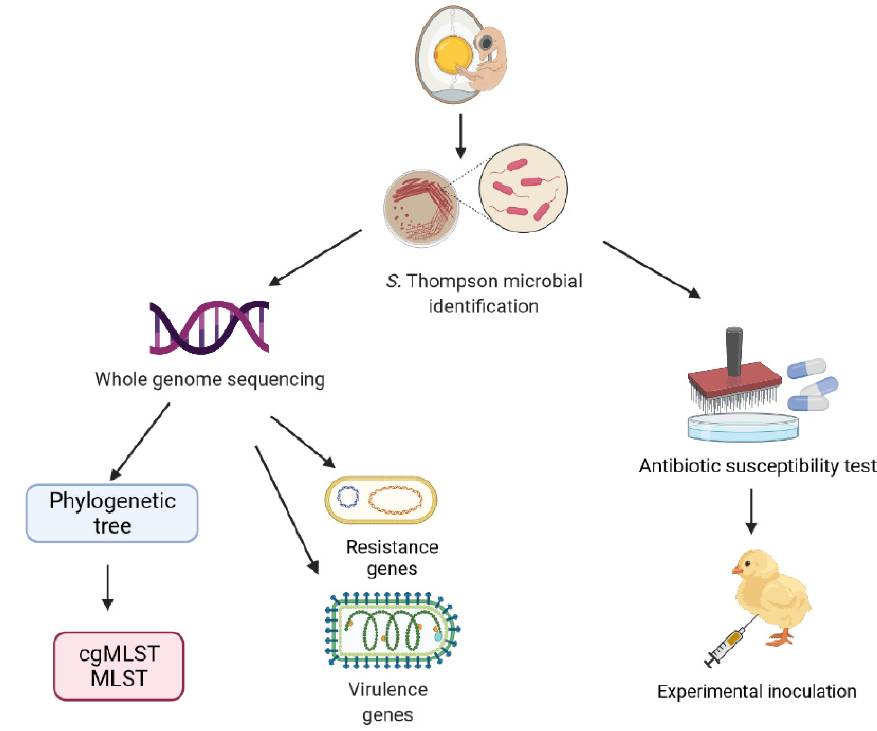
Figure 1. The technical route of the poultry source S. Thompson system research.